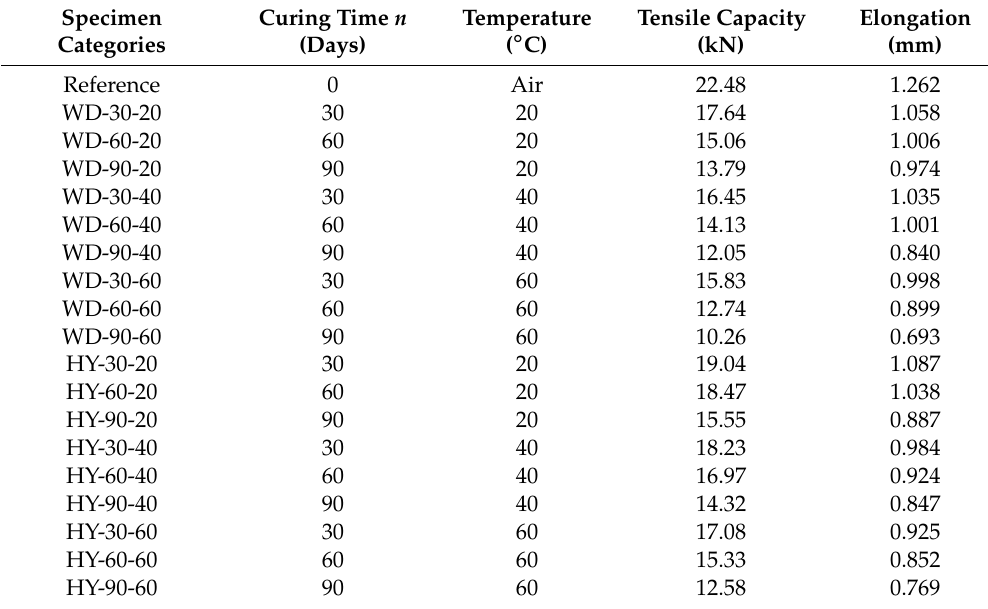
Table 2. Summary of the specimens.